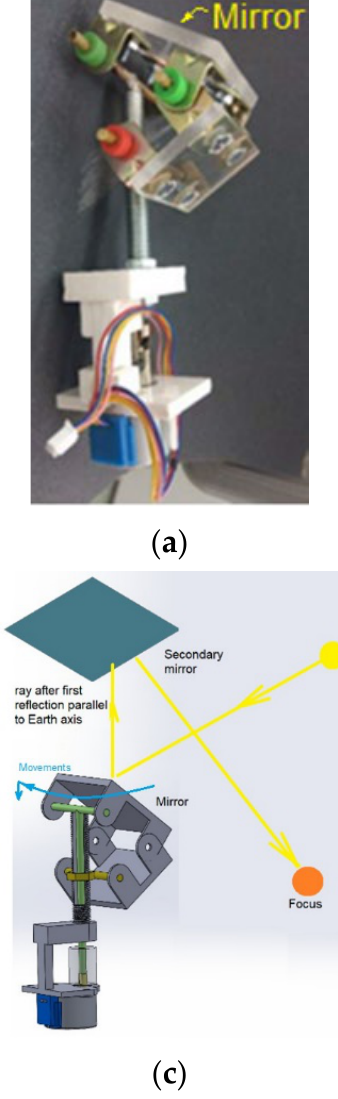
Figure 8. Scale model of the single axis polar heliostats proposed by authors based on Torres et al. (2015). ( a ) Heliostat mechanism used. ( b ) Sectioning of the mechanism used. ( c ) Overall operating principle of the heliostat (blue arrows represent the elementary movements of the primary mirror).